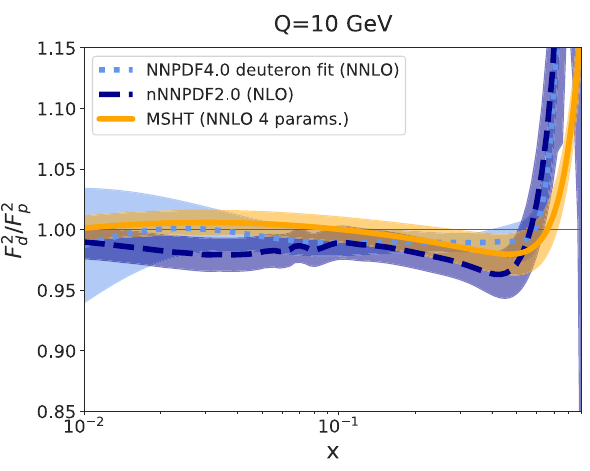
Fig. 56 The ratio of deuteron to the iso-singlet proton structure // F p , 0 functions, F d , evaluated using the proton and deuteron PDFs 2 2 obtained in the present NNPDF4.0 analysis at Q = 10 GeV as a func- tion of x . Results are compared to the nNNPDF2.0 nuclear PDF fit and the phenomenological correction factor from